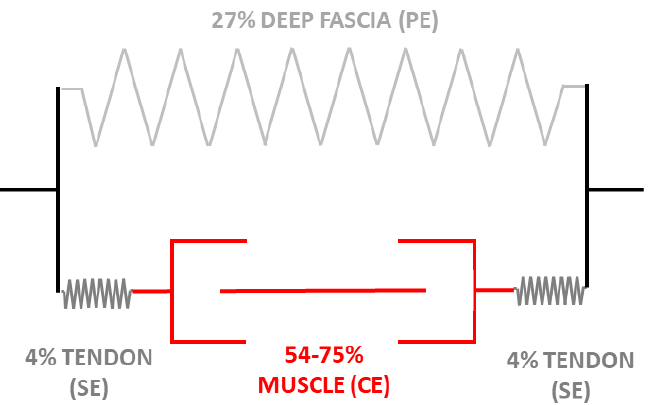
Figure 3. Schematic description of a finite element model based on the Hill’s three-element model (1938) for muscle, fascia, and tendon localize in the inferior limb in anatomical disposition: muscle and tendon are in series, while fascia is in parallel in the leg. During stretching, without muscle contraction, the fascia becomes the first tissue that limits the extension. With muscle contraction, tendon and muscle limit the stretching exercise. CE: Contractile Element; SE: Series Element; PE: Parallel Element. Nerve stiffness or restrictions of e.g., ligaments or skin have not included in this analysis. The plot is based on Morales-Orcajo E. et al. [45], Soderberg, G.L. [46], and Pavan PG et al. [38] publications.